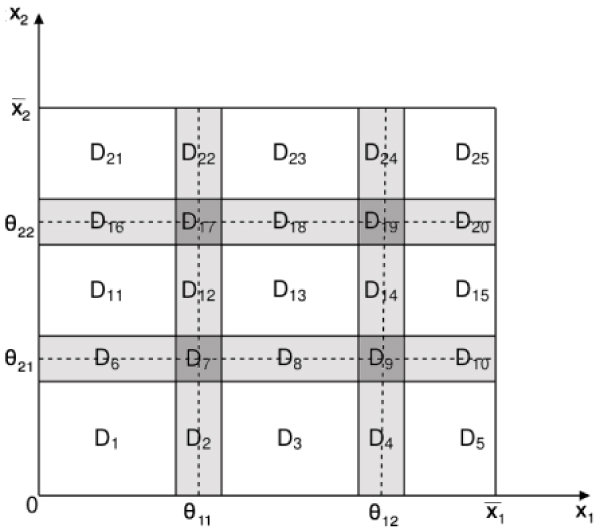
An example of phase space partition. Partition of the phase space associated to a dynamical system with two state variables, where each variable xi ∈ [0, ], i = 1, 2 is associated with two ordered thresholds θij, j = 1, 2. The white rectangles denote regular domains. The gray rectangles denote switching domains, whose width, δ > 0 is a monotonic function of the parameter q with δ(q) → 0 for q → 0. In the light gray regions one variable is switching and the other one is regular, whereas in the dark gray ones both variables are switching.